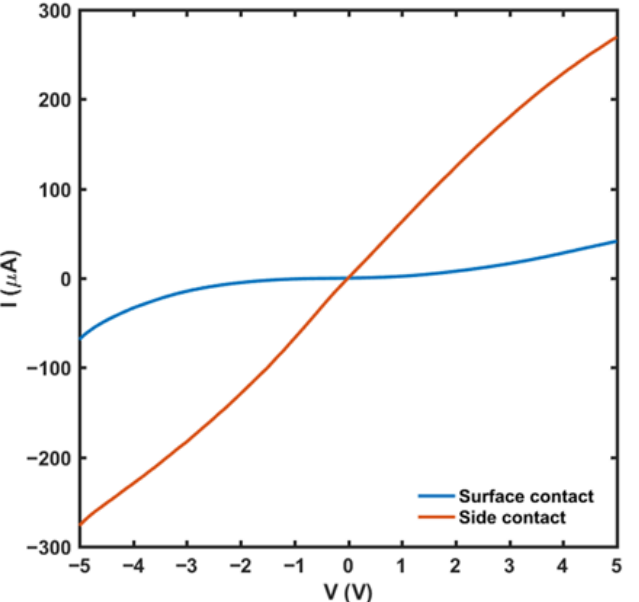
Figure 6. The I-V characteristics of the surface contact and side contact mode with the electrode distance of 40 μ m when not annealed.